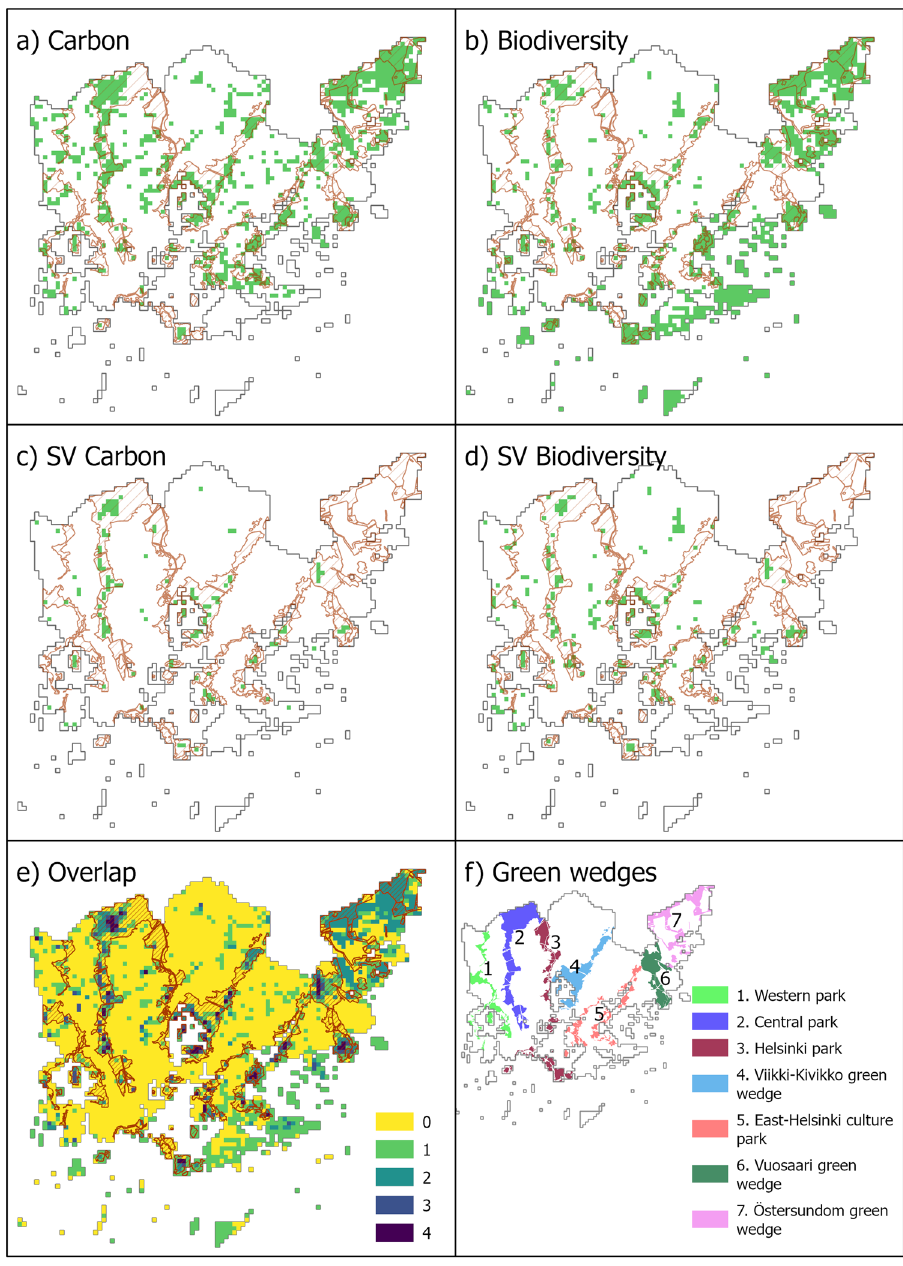
Fig. 3 Spatial overlap of biophysical and social values for carbon and biodiversity. Top 20% locations for a CO 2 fl ux, b Biodiversity, c SV for Carbon, d SV for Biodiversity and e number of overlapping indicators from a – d . Graduate colour schemes scaled by quantiles. e Sum of all top 20% locations. f location of green